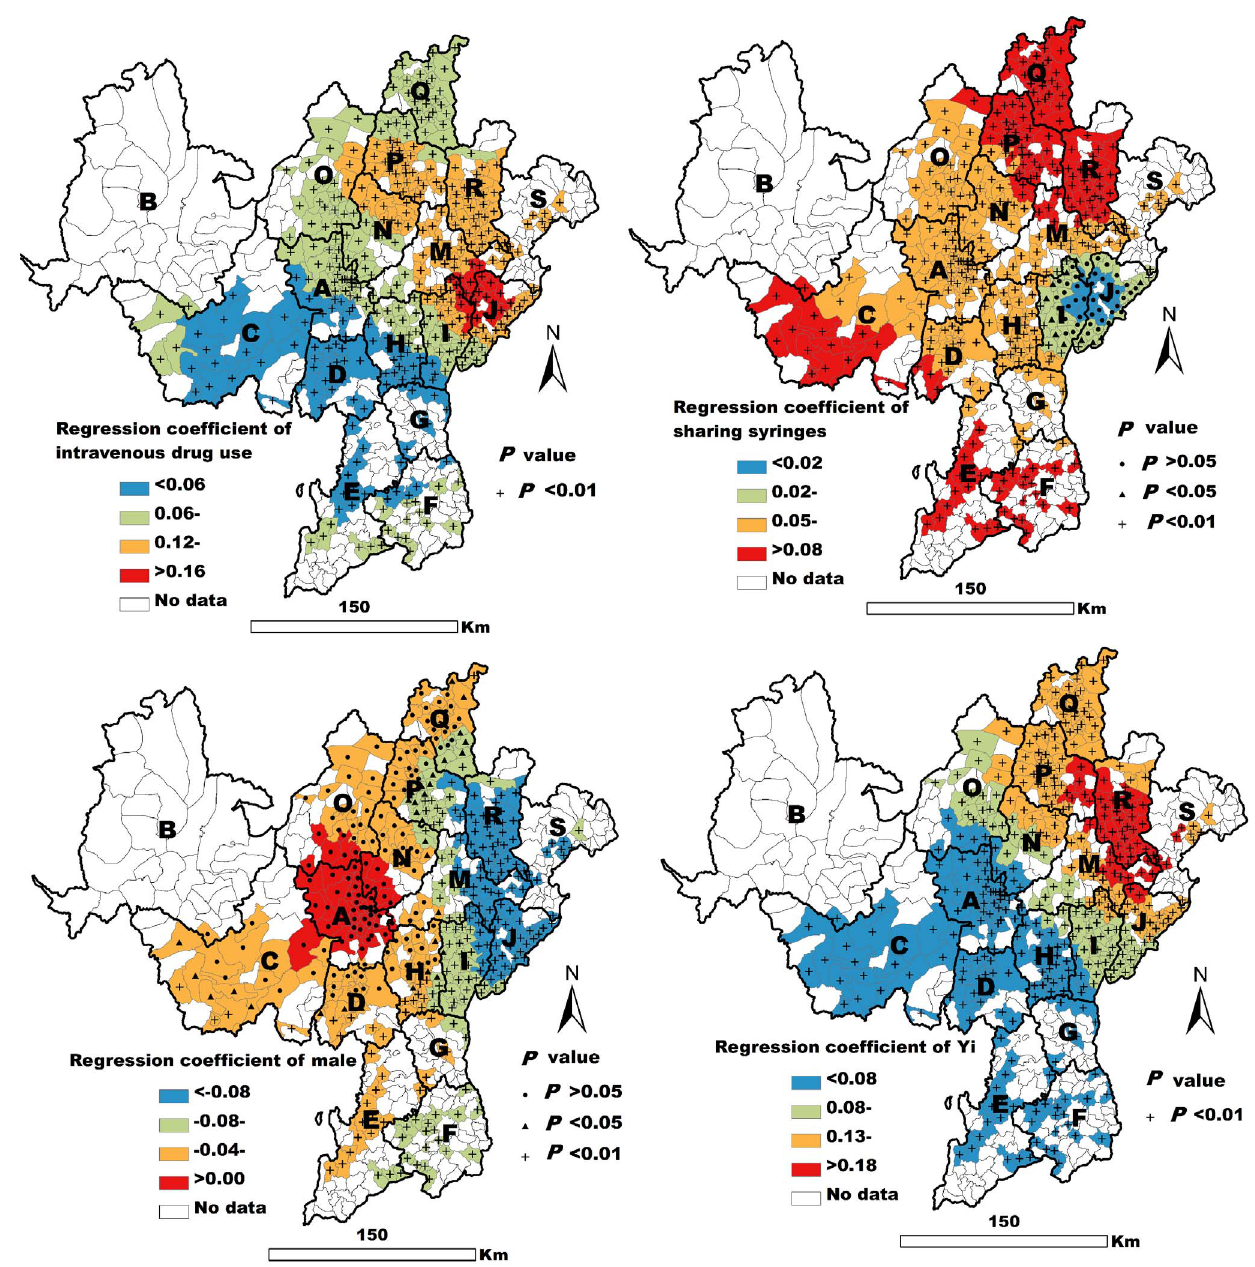
Figure 6. Spatial distribution of the GWR coefficients of four variables associated with HIV/HCV co-infection.